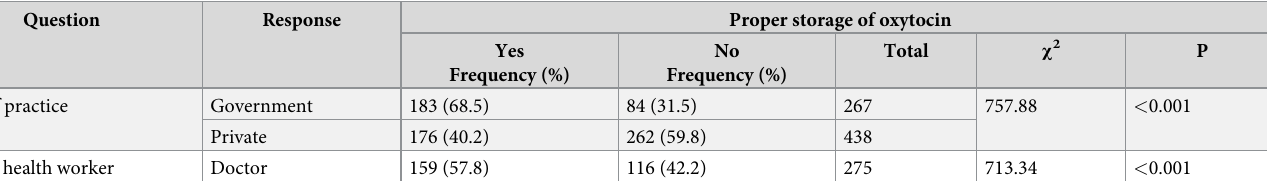
Table 11. Factors affecting knowledge of proper storage of